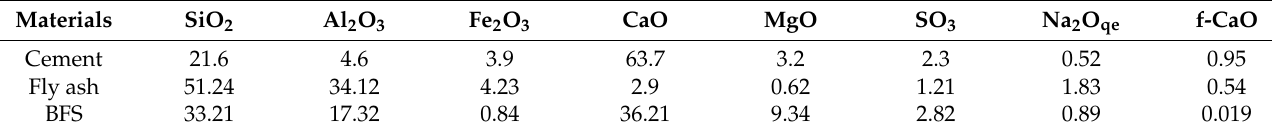
Table 1. Chemical compositions of cement (%).